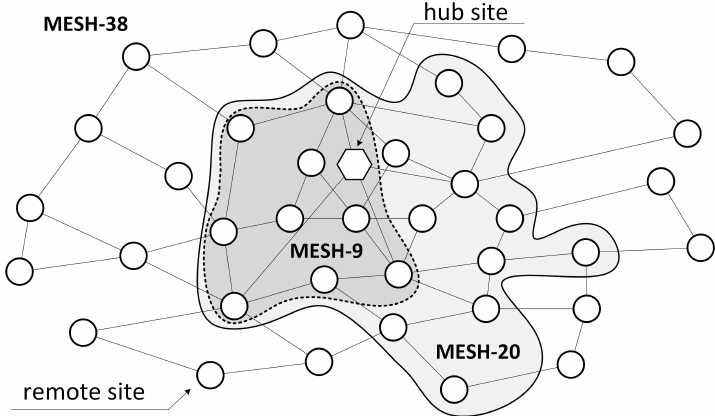
Figure 3. Network topologies studied, where MESH-9 and MESH-20 are the subgraphs of MESH-38.